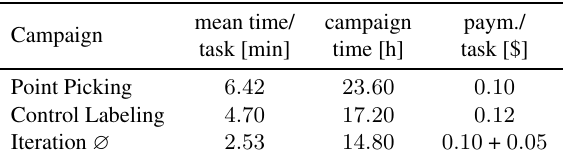
Table 2. Statistics of all conducted crowd campaigns.